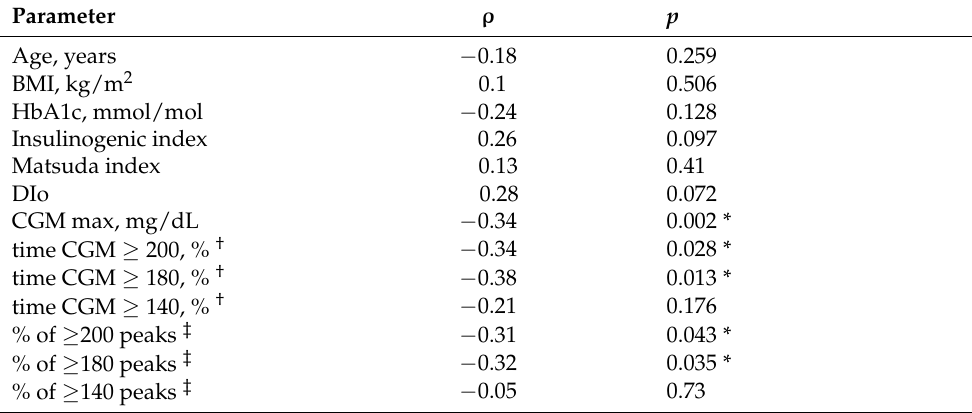
Table 3. Spearman’s rank-order correlation coefficients ( ρ ) of associations between indices for postprandial hyperglycemia and